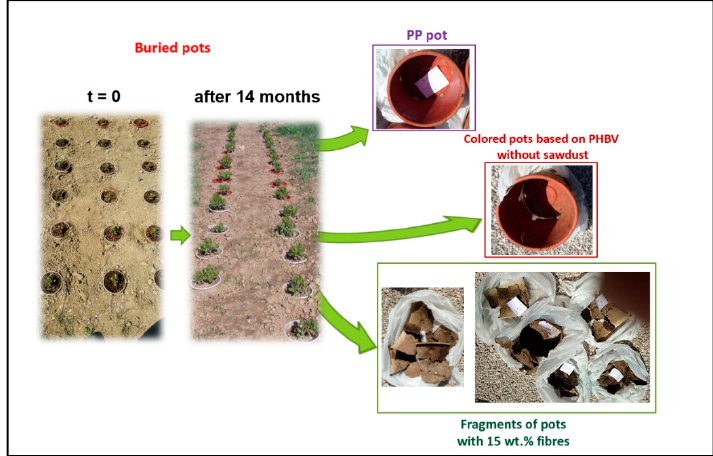
Figure 5. Buried PP and PHB-HV based pots without fibers and with 15 wt % sawdust fibers.